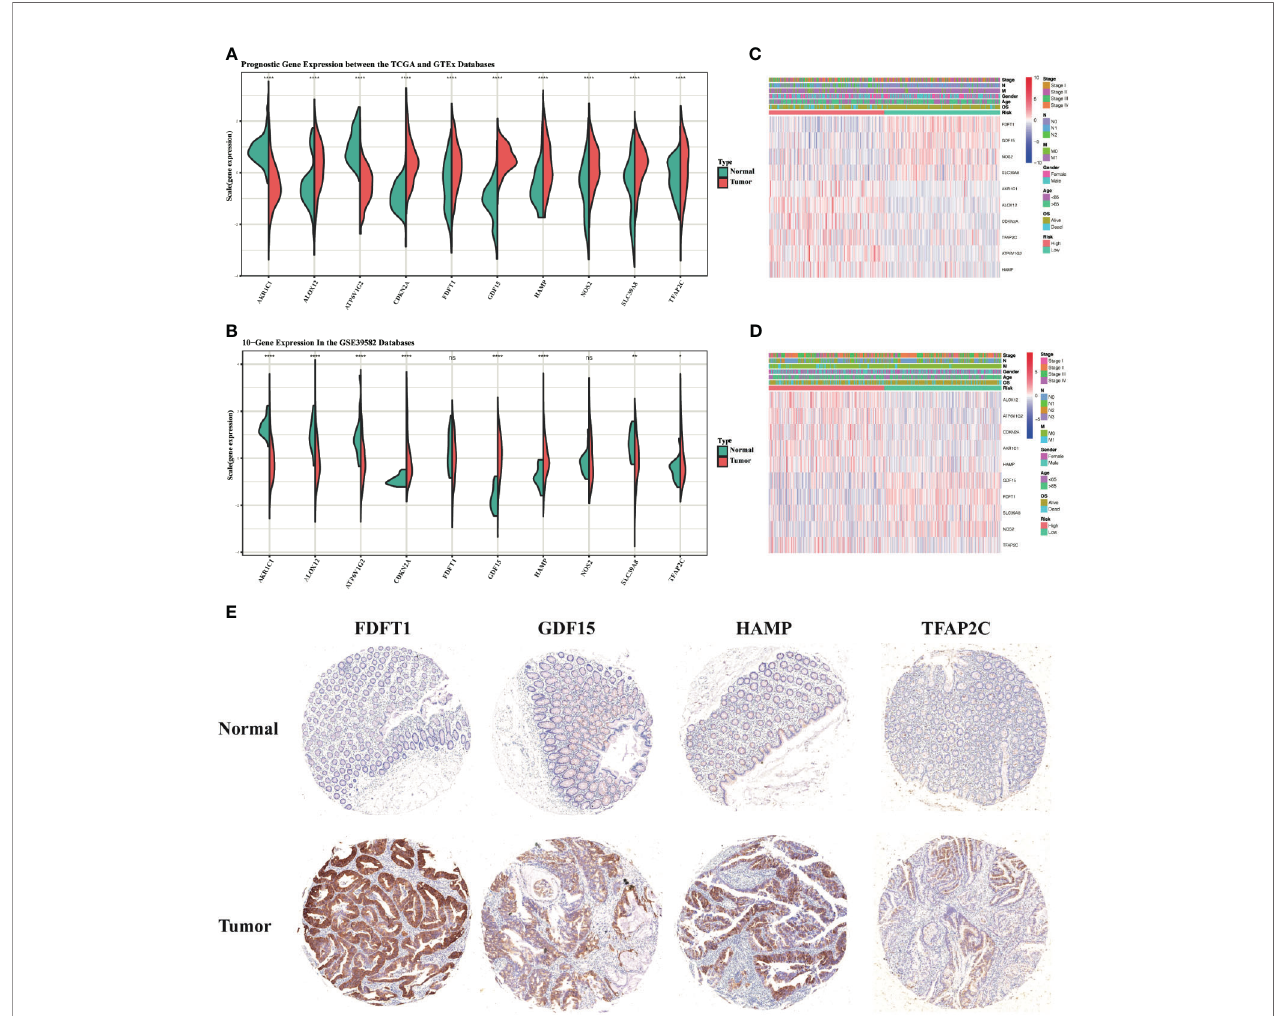
FIGURE 13 | The boxplots of the different expression levels of the 10 ferroptosis-related genes between the normal and tumor colon tissues in the training (A) and testing (B) datasets. The heatmaps for the different expression levels of these 10 genes and the clinical characteristics between the high-risk and low-risk groups in the TCGA (C) and GSE39582 (D) datasets. Representative immunohistochemistry images (E) of FDFT1, GDF15, HAMP, and TFAP2C in CRC tissues and corresponding normal tissues. *p < 0.05, **p < 0.01, ****p < 0.0001. ns, no signi fi